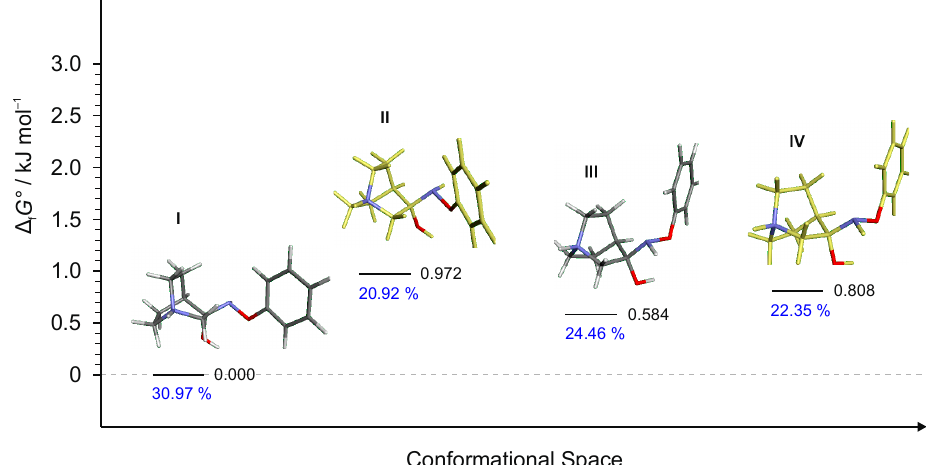
Figure 10. Lowest energy conformers of RI3 and their relative standards Gibbs energies of formation Δ f G °calculated at the B3LYP-D3/6-311++G(d,p) level of the theory. (Relative fractions according to Boltzmann distribution at 298.15 K are given in blue. Conformer RI3 - III was not found.)